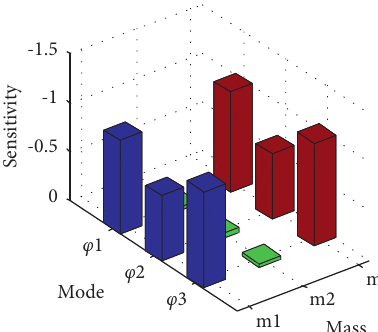
Figure 11: Histogram of the second mode sensitivity matrix.